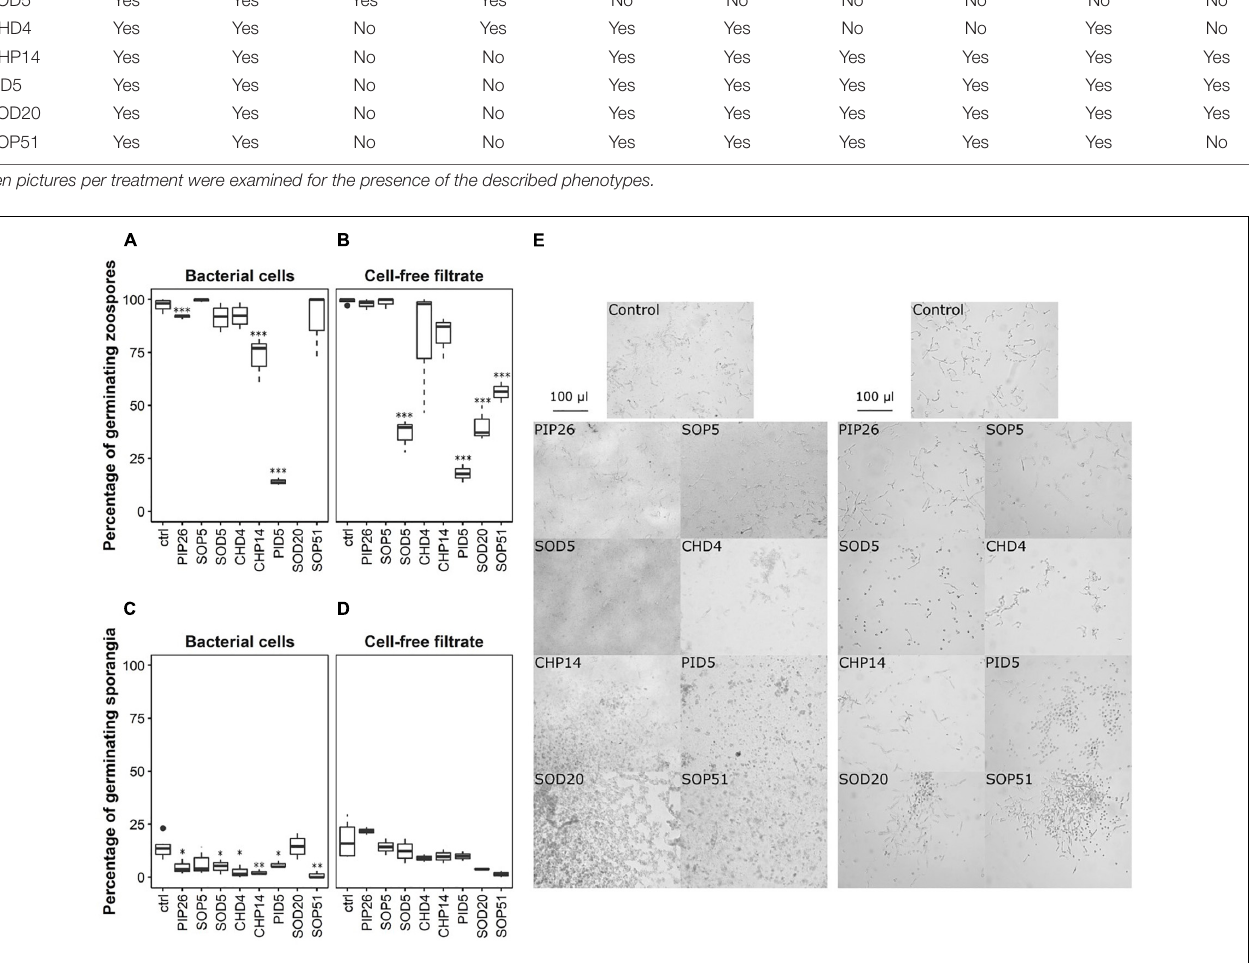
FIGURE 6 | Inhibition of zoospore and sporangia germination of P. infestans. Percentages of germinated zoospores observed after 4 h upon exposure to bacterial cells are shown in (A) , those observed upon exposure to cell-free filtrates are shown in (B) . Percentages of germinated sporangia after 24 h upon exposure to bacterial cells and to cell-free filtrates are shown in (C,D) respectively. Stars indicate significant difference in germination percentage compared with the respective control (ctrl) according to a t -test ( ∗ p < 0.05; ∗∗ p < 0.01; ∗∗∗ p < 0.001). Both experiments were replicated once, generating two datasets of which one is represented in this figure, and three technical replicates were prepared, except for the effect of the cell-free filtrates on sporangia germination, for which only two technical replicates were analyzed. Per technical replicate, one picture was taken and analyzed. Representative pictures of zoospores co-incubated with bacterial cells (left) or cell-free filtrates (right) are shown in (E) . The experiment was repeated twice with similar